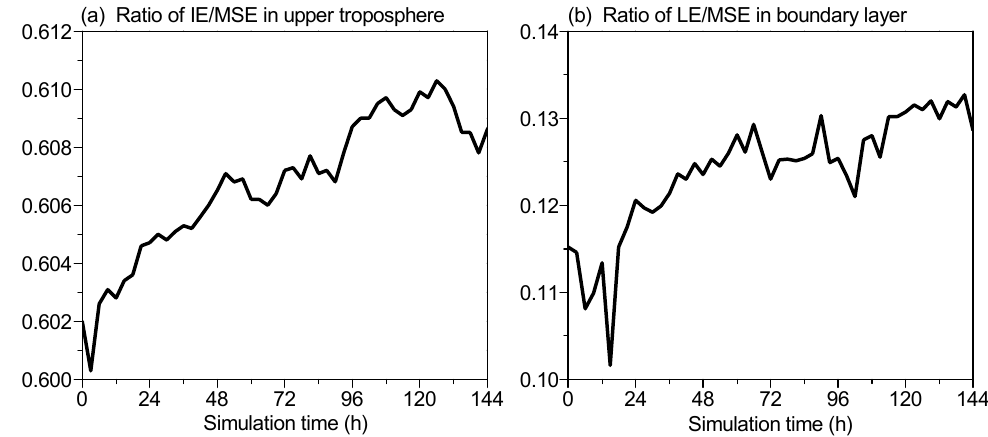
Figure 6. Time evolution of azimuthal and radial mean ratio of ( a ) IE to MSE in the upper troposphere (height of approximately 14 km), and ( b ) LE to MSE in the boundary layer (height of approximately 1 km).